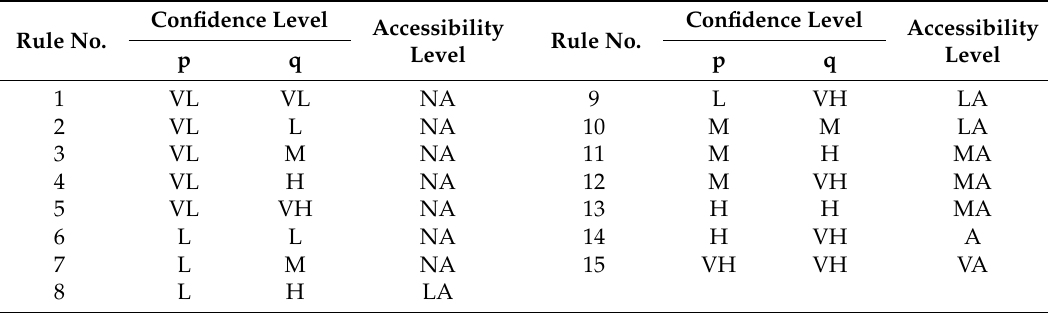
Table 2. Defined if-then rules between two variables of p & q.